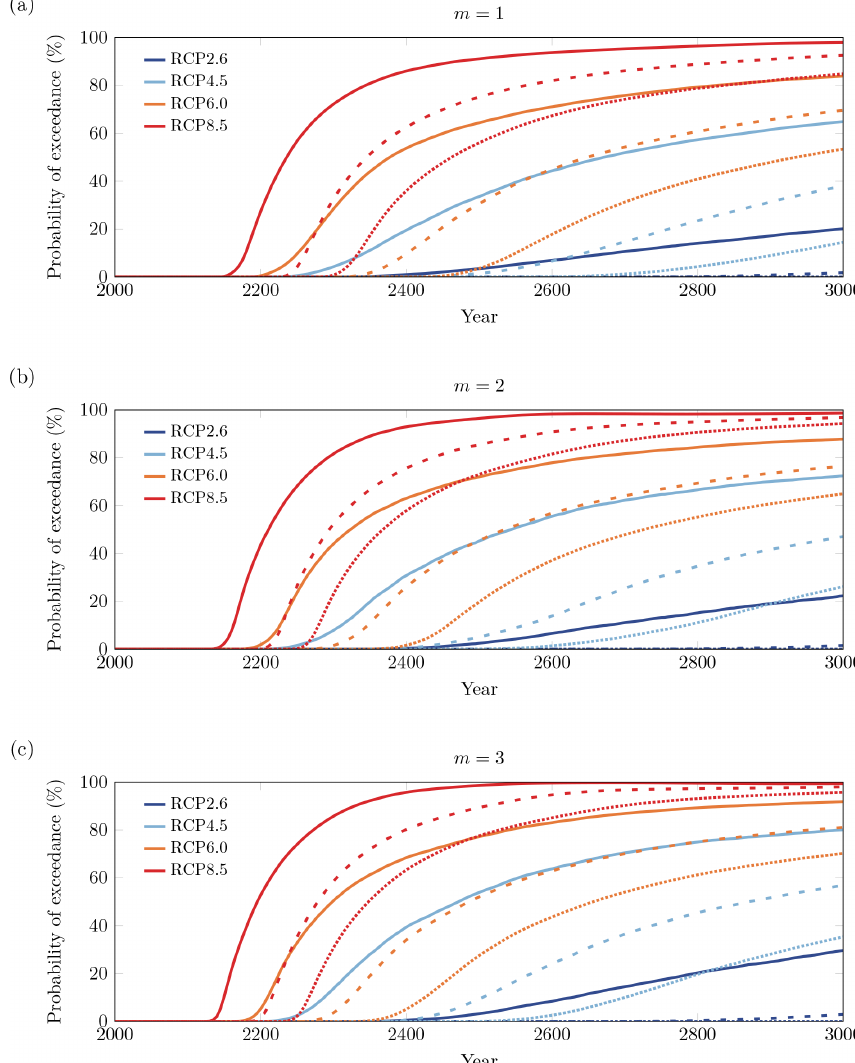
Figure 8. Probability of exceeding some characteristic threshold sea-level rise values as a function of time, evaluated from the complementary cumulative distribution functions of the probability density functions for (cid:49) GMSL. Probability of exceedance under (a) the viscous sliding law, ( b ) the weakly non-linear sliding law and (c) the strongly non-linear sliding law. Solid lines correspond to a threshold value of 0.5m, dashed lines to a threshold value of 1m and dotted lines to a threshold value of